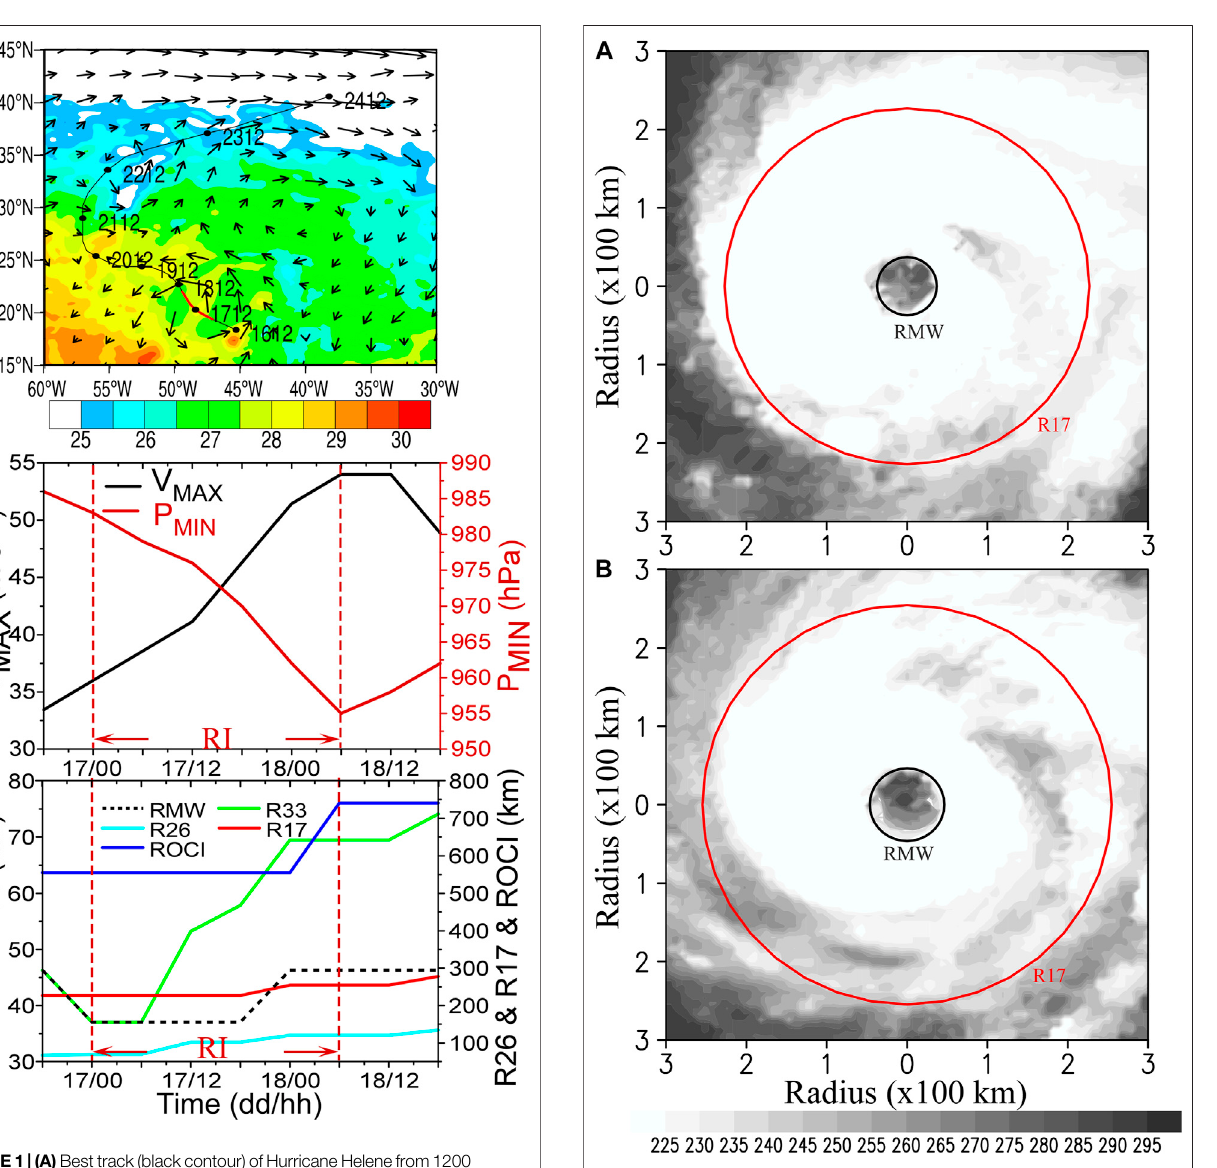
Frontiers in Earth Science |